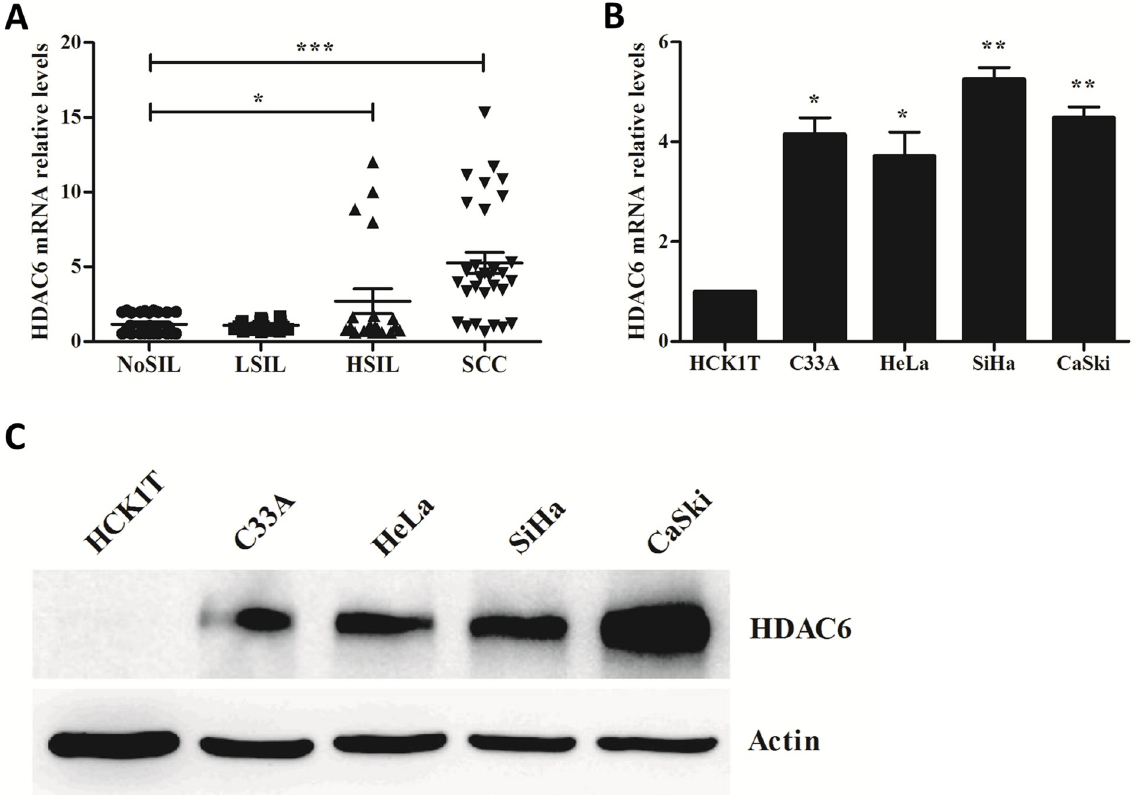
Fig 2. HDAC6 was up-regulated in cervical cancer tissues and cell lines. A. The relative levels of HDAC6 in the different grades of fresh- frozen cervical tissues. B. The relative levels of HDAC6 in four cervical cancer cell lines and one immortalized human cervical keratinocyte line (HCK1T). The levels of HDAC6 were measured by qRT-PCR and normalized with GAPDH. C. The expression levels of HDAC6 protein in four cervical cancer cell lines and one immortalized human cervical keratinocyte line (HCK1T) were measured by western blotting. � P < 0.05, �� P < 0.01, ��� P <